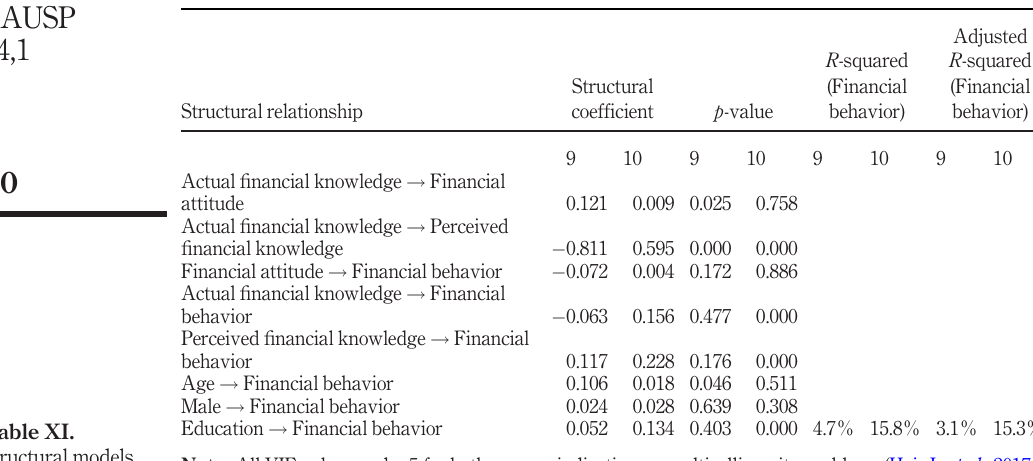
Table XI. Structural models Groups 9 and 10 – Results